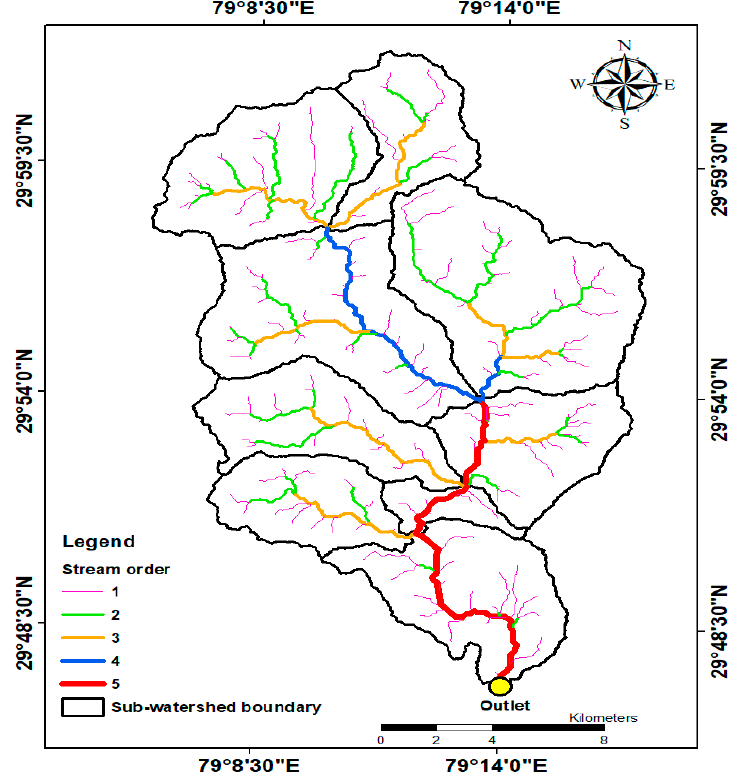
Figure 3. Stream order map of the nine sub-watersheds of BW.